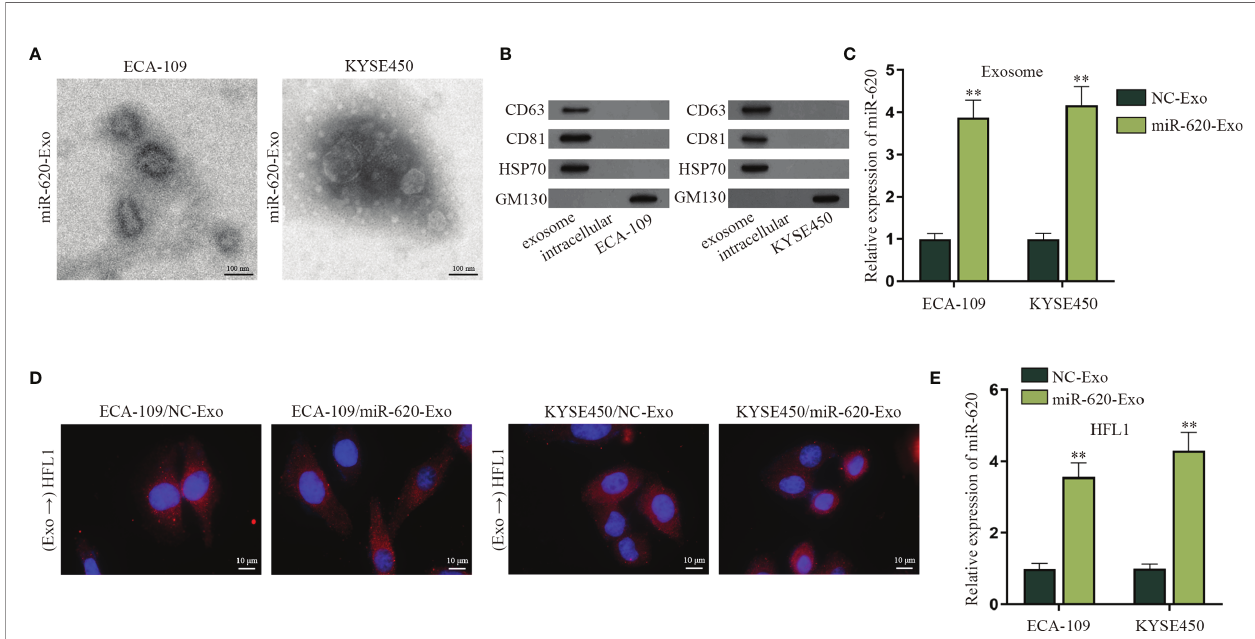
FIGURE 5 | Exosomal miR-620 is highly secreted in ESCC. (A) The morphology of exosomes secreted from miR-620-overexpressed ESCC cells was observed through electron microscopy. (B) Western blot was used to detect the protein expression of exosome-speci fi c marker proteins (CD63, CD81, and HSP70) and the negative marker GM130 in ESCC cells receiving miR-620-Exo. (C) The expression of miR-620 in NC-Exo and miR-620-Exo groups was detected by qRT-PCR. (D) Fluorescence microscope was applied to observe the fl uorescence of lung fi broblast cells (HFL1) receiving ECA-109/miR-620-Exo and KYSE450/miR-620-Exo. (E) The expression of miR-620 in HFL1 cells receiving miR-620-Exo was detected by qRT-PCR. ** p <